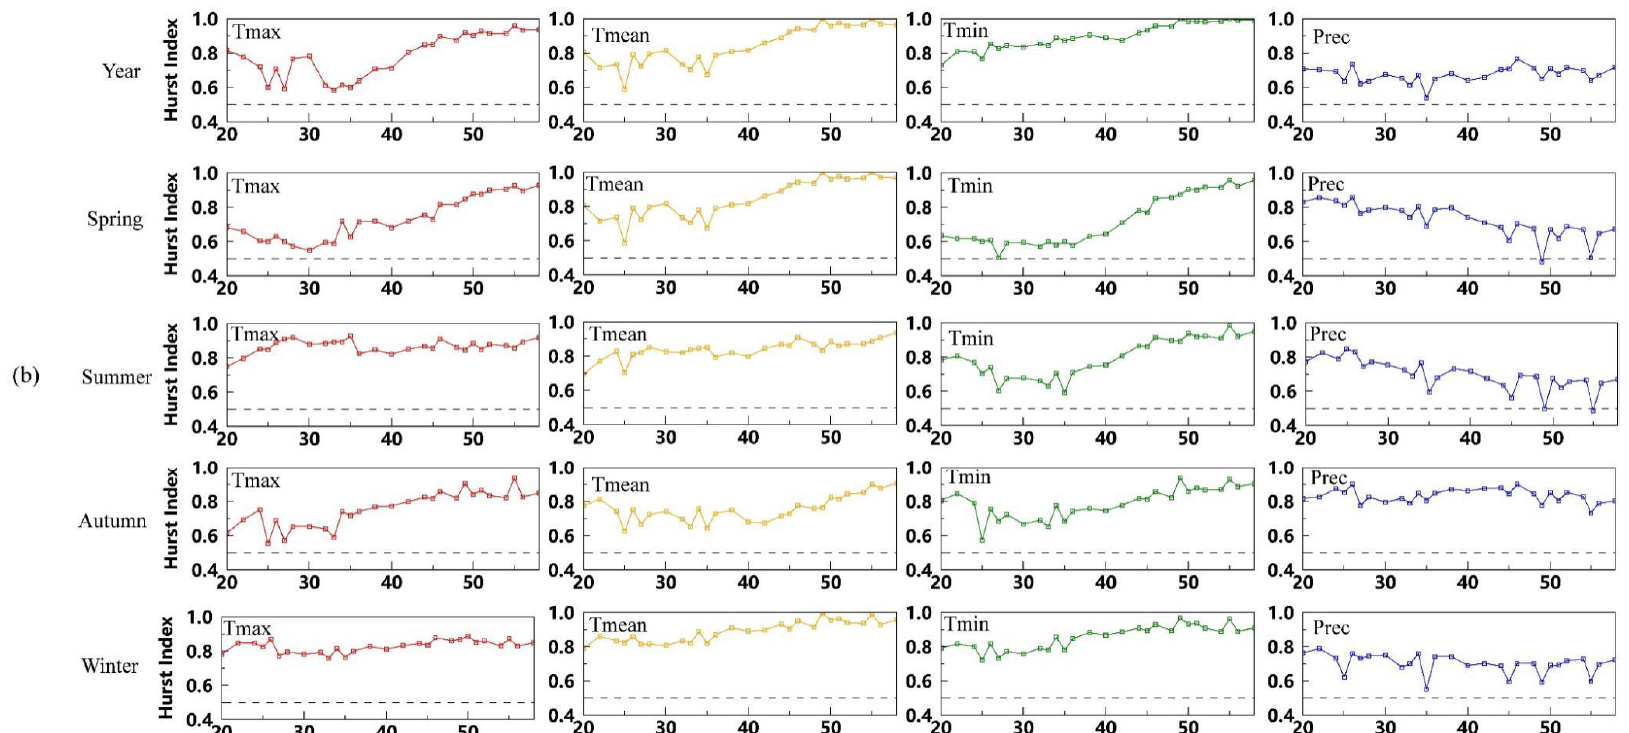
Figure 3. Results of the Hurst index experiment on temperature and precipitation in the Yellow River Basin. ( a ) Results of the 20-year Hurst index experiment; ( b ) Results of the Hurst index accumulation experiment. Red is the maximum temperature; orange is the average temperature; green is the minimum temperature; and blue is the precipitation amount.